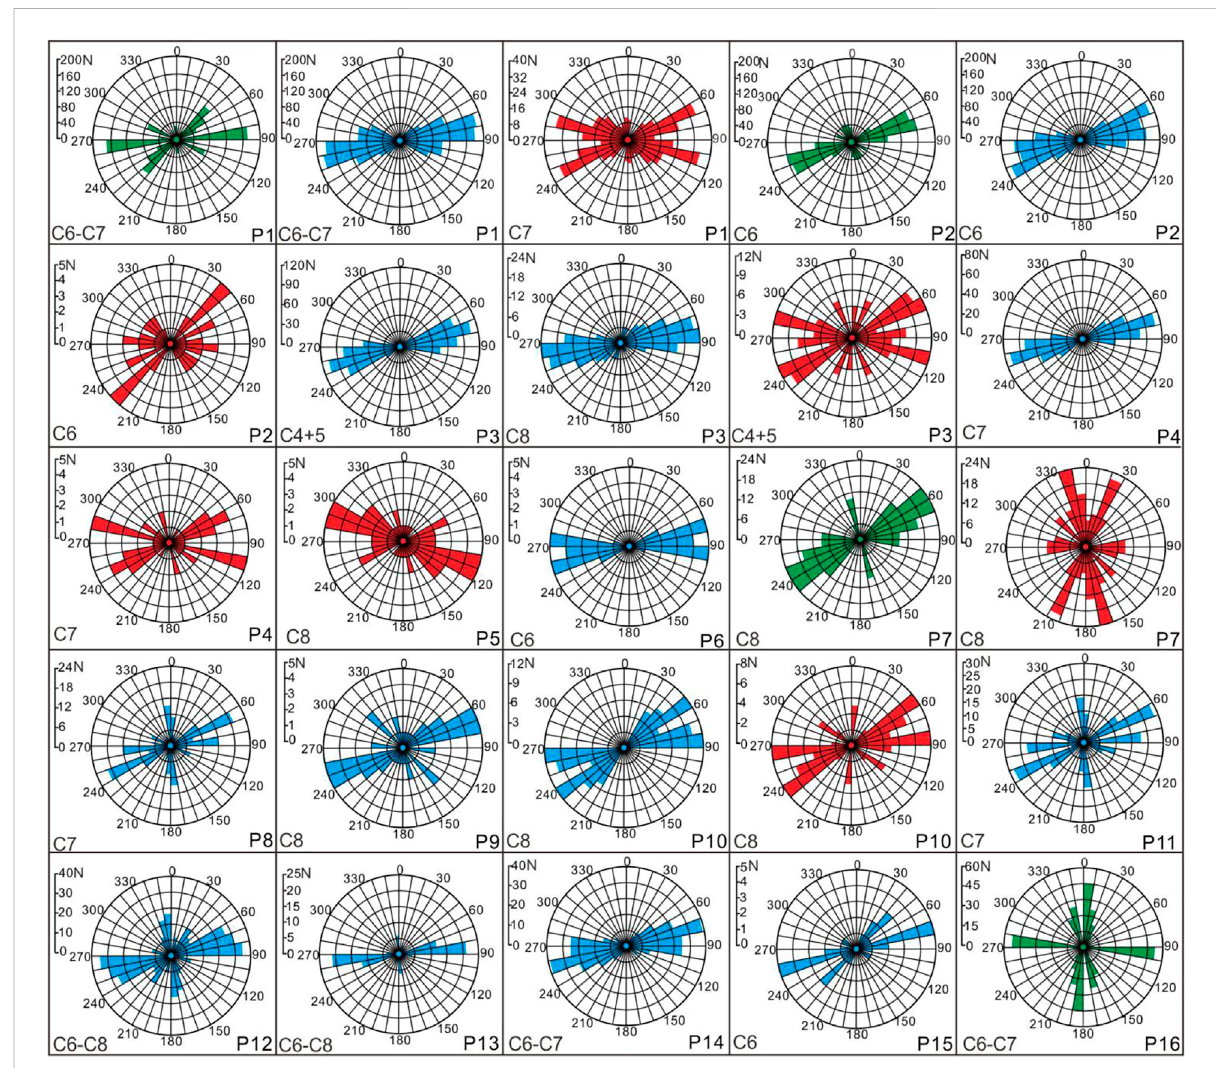
FIGURE 3 Fracture strike rose diagrams for different areas. Green represents fractures in fi eld statistics, red represents fractures determined by core paleomagnetism, and blue represents fractures in imaging logging statistics. P1-P16 are the locations of the fracture observation points, and C4-C8 arethedifferentoil-bearingformationsoftheYanchangFormation.C4+5=Chang4+5oil-bearingformations;C6=Chang6oil-bearingformation; C7 = Chang 7 oil-bearing formation; C8 = Chang 8 oil-bearing formation. See Figure 1 for the P1-P16 locations. Some imaging logging and paleomagnetic data in the western Ordos Basin were provided by Fan et al.